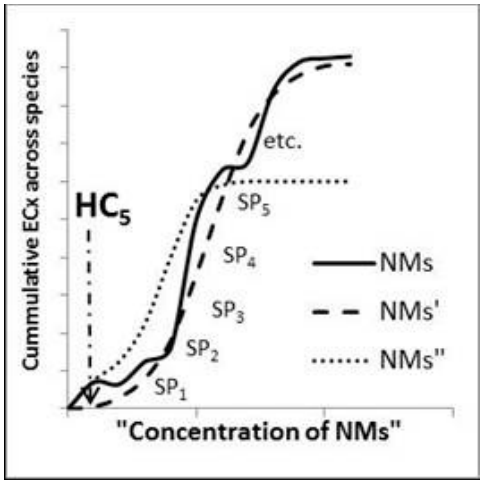
Figure 9. Illustration of the probabilistic based approach to derive PNEC, where cumulative curves are built over the toxicity data and a Hazard Concentration 5 (HC5) is statistically derived. NMs, NMs ′ and NMs ′′ refer to the changes in NM form during different stages of the life cycle. SP 1 , SP 2 , etc. refer to different species.